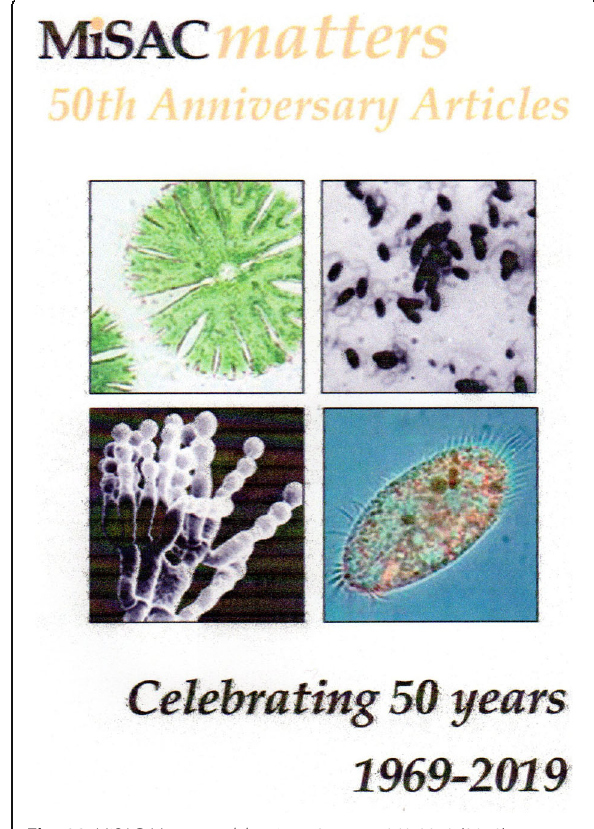
Fig. 23 MiSAC Matter:s celebrating 50 years 1969-2019 (2019)